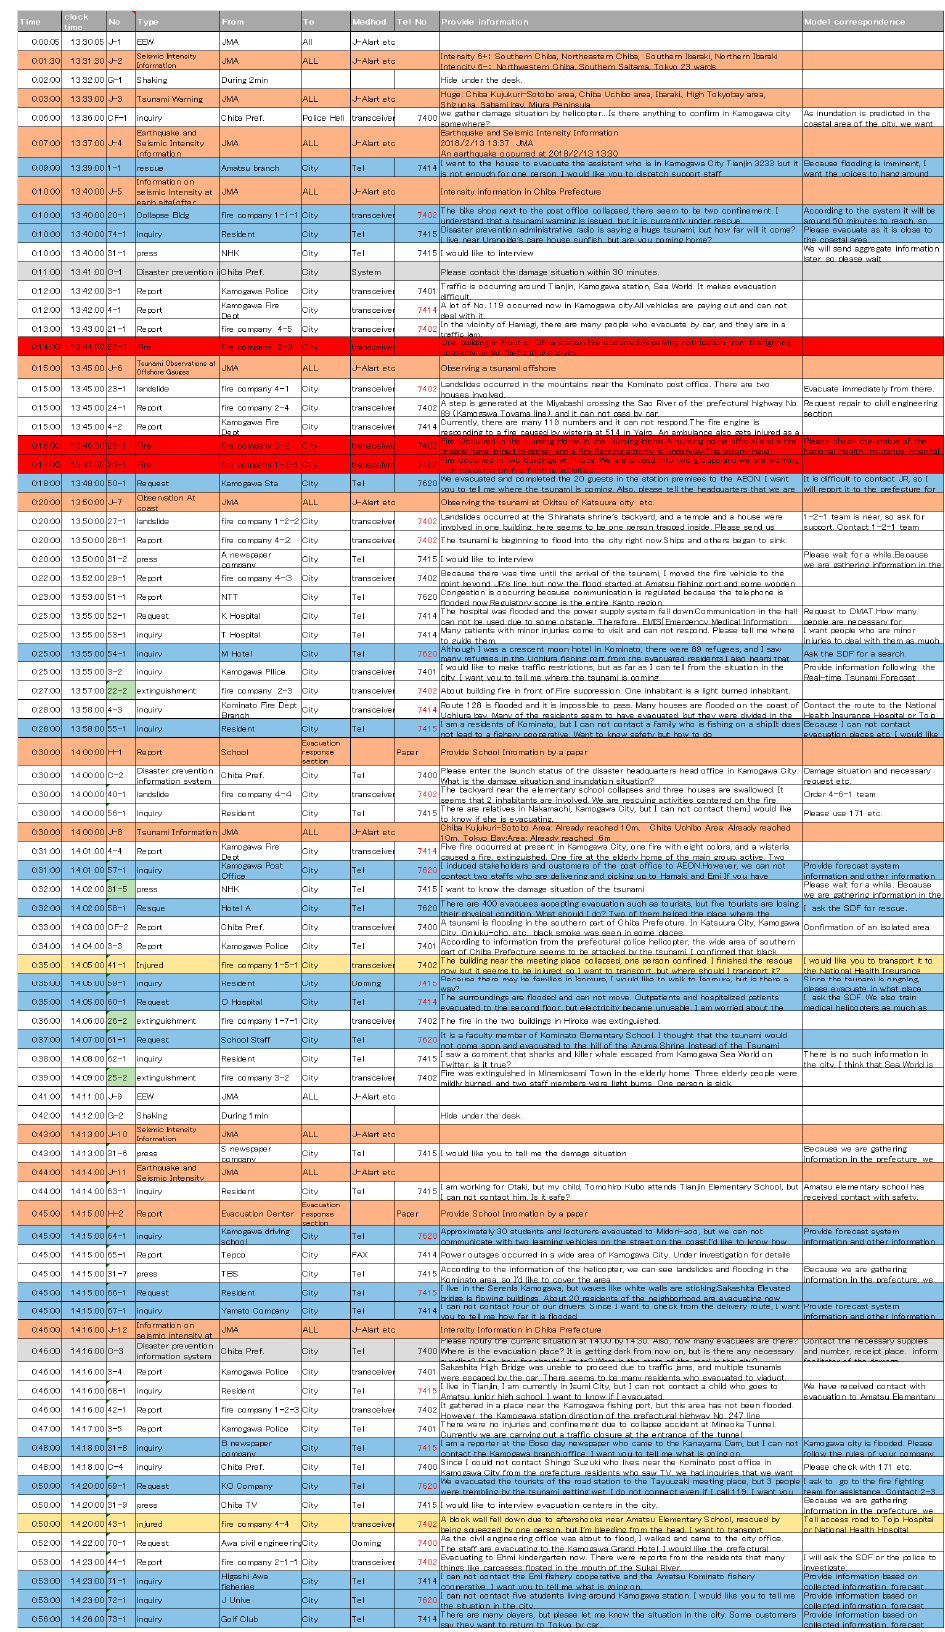
Figure 6. The information list of the TTX. The location of events is shown in Figure 7. The blue line shows inquiries or rescue requests due to the tsunami disaster. The red line shows the requests